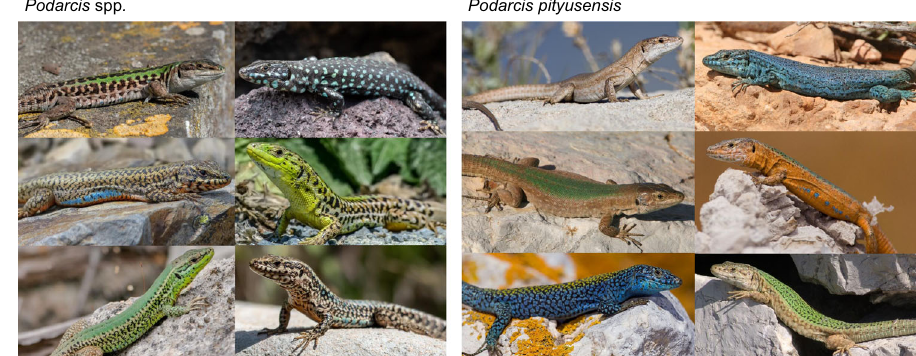
Fig. 1 Phenotypic diversity of wall lizards. Left panel shows representative male phenotypes of six Podarcis species: P. siculus (top left), P. fi lfolensis (top right), P. erhardii (middle left), P. tauricus (middle right), P. waglerianus (bottom left) and P. muralis (bottom right). Some Podarcis species are extraordinarily variable, as illustrated by the right panel that shows representative male phenotypes of six distinct populations of Podarcis pityusensis , a species endemic to Ibiza, Formentera and adjacent islets. Photo credits: Birgit and Peter Oe fi nger (https://www.eurolizards.com/) for all six species on the left panel, and for P. pityusensis Day ’ s Edge Productions (top left, middle right, bottom left) and Mike Zawadzki (top right, middle left and bottom